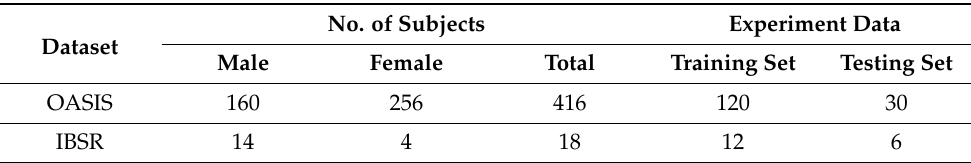
Table 1. Summary of OASIS and IBSR datasets used in our experiments.